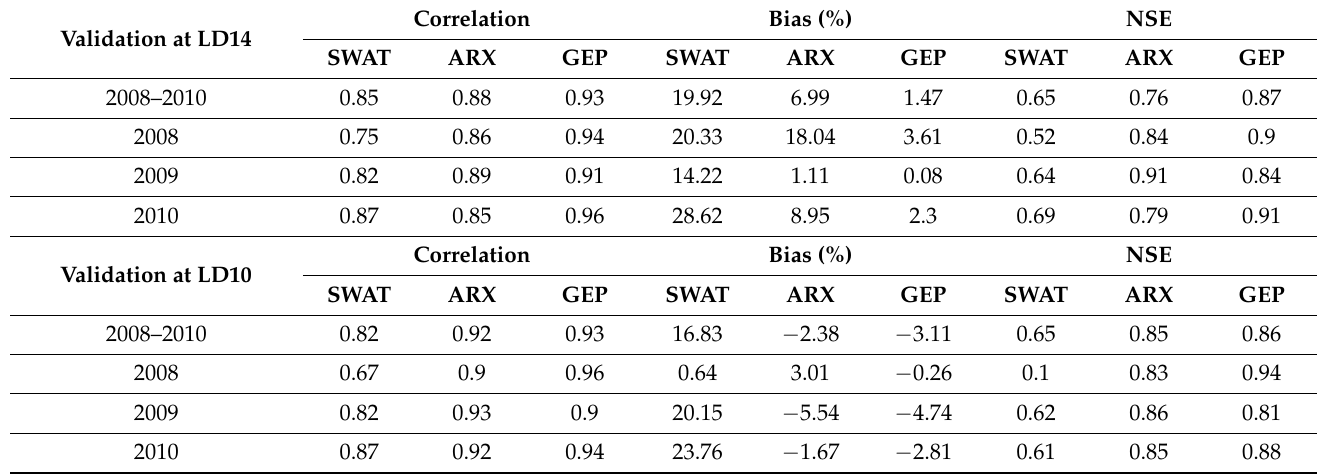
Table 4. Performance evaluation statistics of SWAT, ARX, and GEP model for validation at LD14 and LD10. Validation at